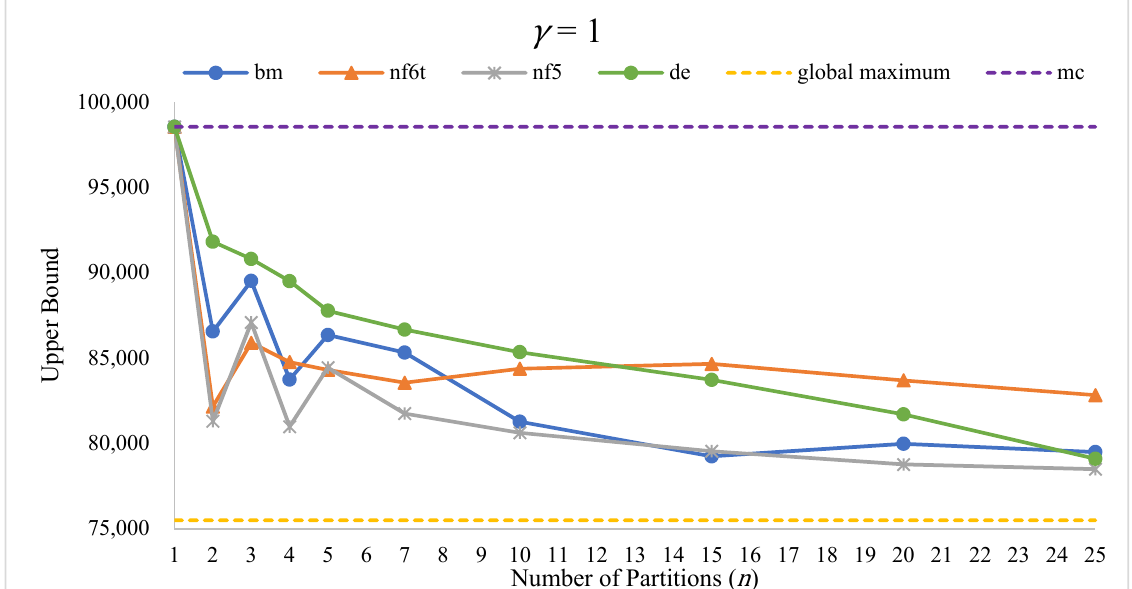
Figure 5. Convergence-indicating curves of the bm , de , nf5 , and nf6t relaxation schemes for 𝛾 = 0.5.